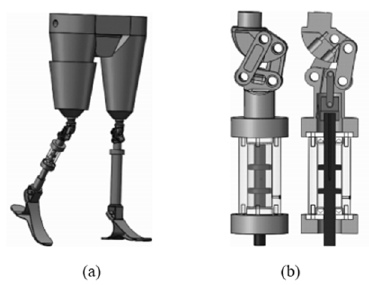
Figure 20. A prosthetic system with MRD [117]: ( a ) MRD prosthetic knee joint ( b ). Virtual prototype model of the lower limb.